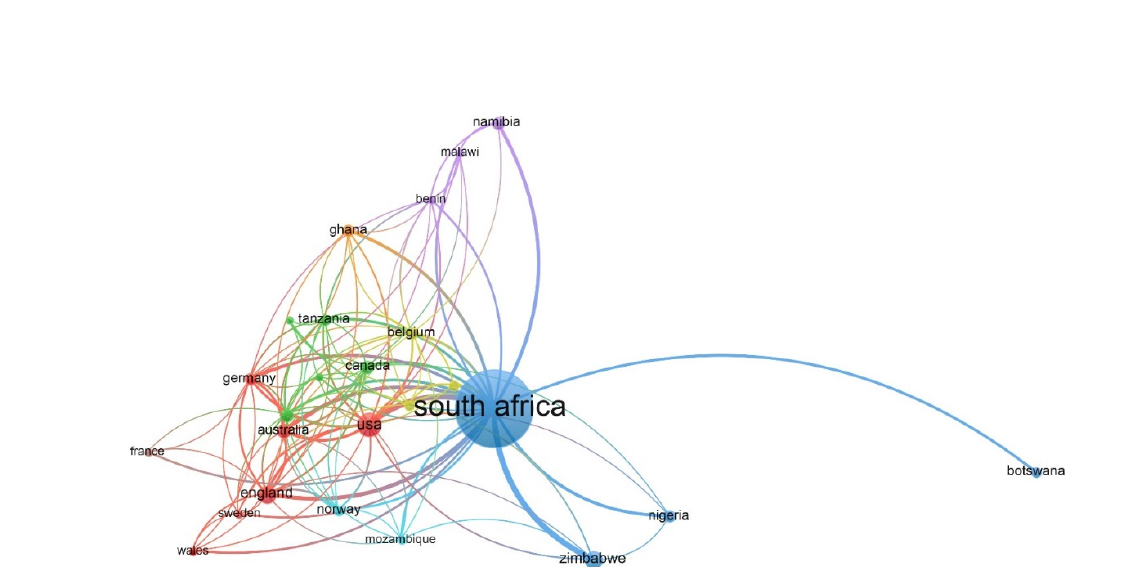
Figure 6. Network visualization map of publishing countries on indigenous knowledge literature: ( a ) global view, ( b ) African view, and ( c ) South African view.